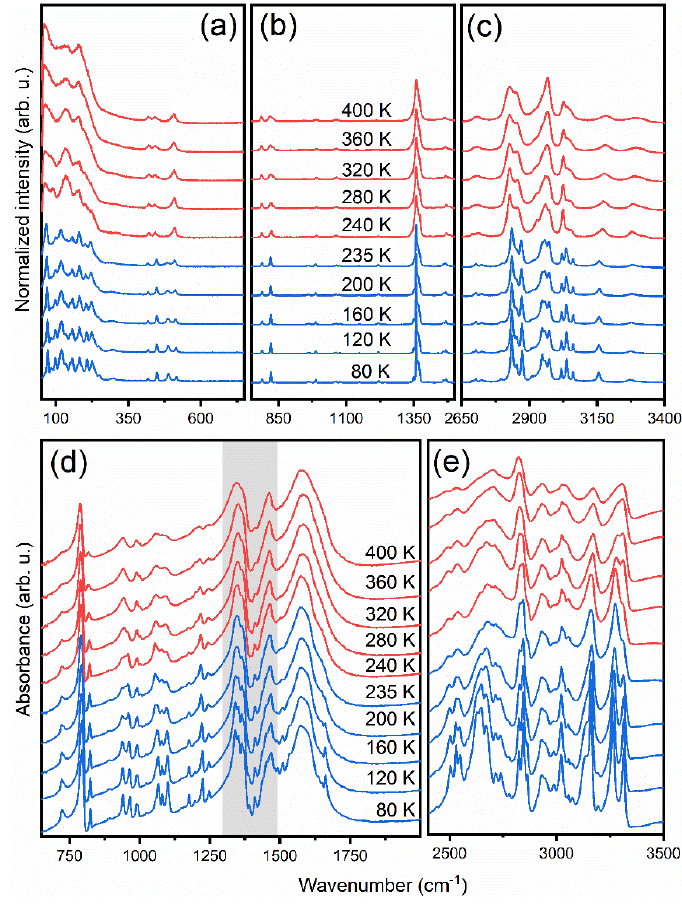
Figure 3. Temperature-dependent Raman spectra measured form single-crystal in the ( a ) 50–750 cm − 1 , ( b ) 750–1500 cm − 1 and ( c ) 2650–3400 cm − 1 ranges compared to temperature-dependent polycrystalline IR spectra measured in nujol ( d ) and Fluorolube ( e ). The grey range in ( d ) was not analysed due to the coexistence of bands corresponding to the nujol and sample. The ν 2 and ν 4 bands corresponding to stretching modes involving oxygen atoms exhibit downshifts by 1.1–4.2 cm − 1 and upshift by 4.1 cm − 1 , respectively, at the PT tem- perature. The ν 4 and one of the ν 2 Raman bands exhibit strong broadening at the PT temperature upon heating, by 14.7 cm − 1 and 7.7 cm − 1 , respectively. Interestingly, the second ν 2 Raman band exhibits unusual narrowing by 3.5 cm − 1